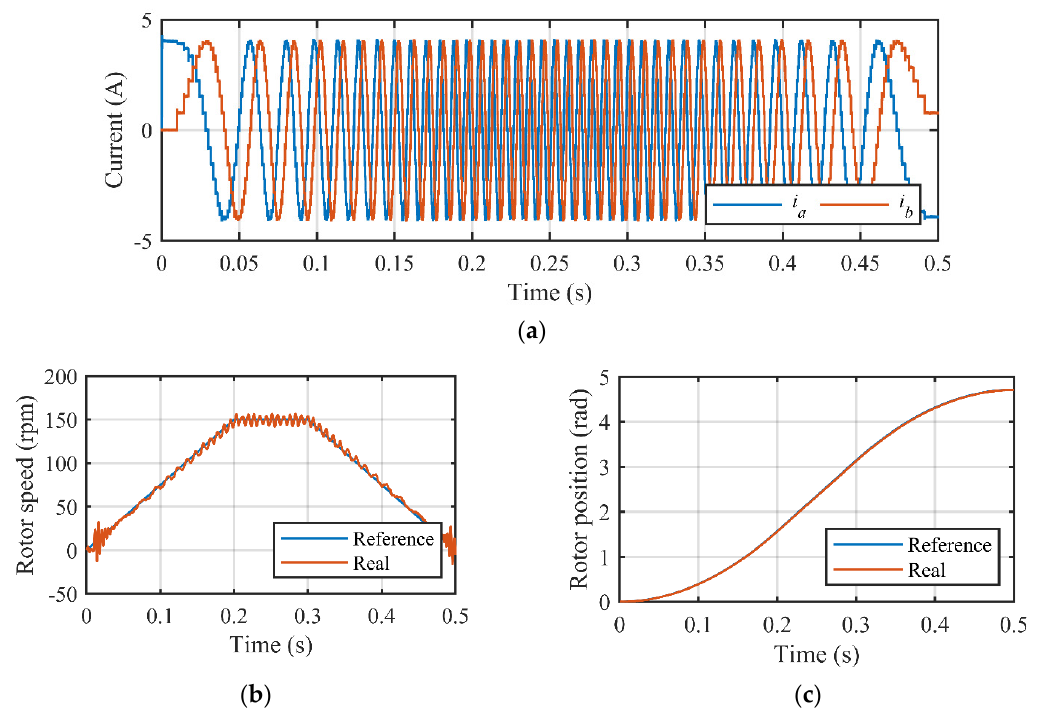
Figure 16. Microstepping ( a ) stator winding currents, ( b ) rotor speed response, and ( c ) rotor position response under trapezoidal reference speed profile.